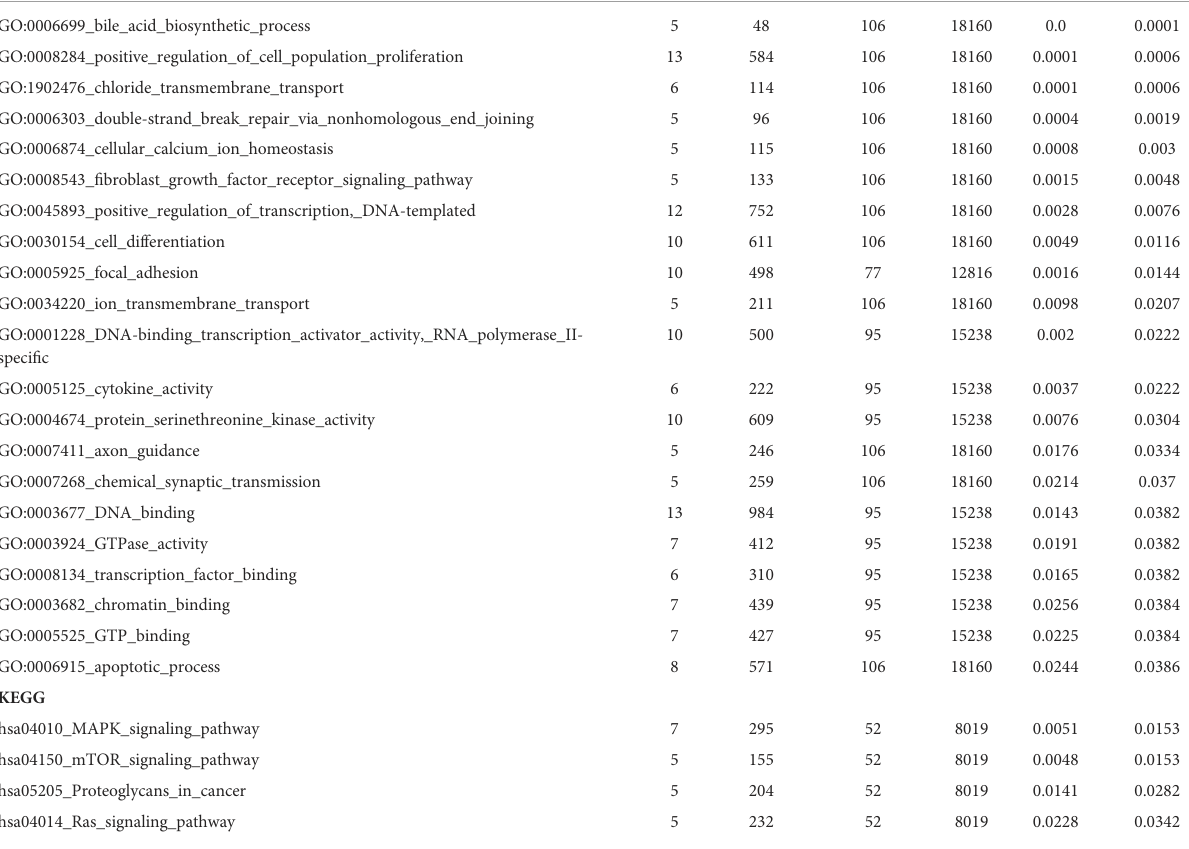
TABLE 2 Gene set enrichment analysis of target genes for hsa-